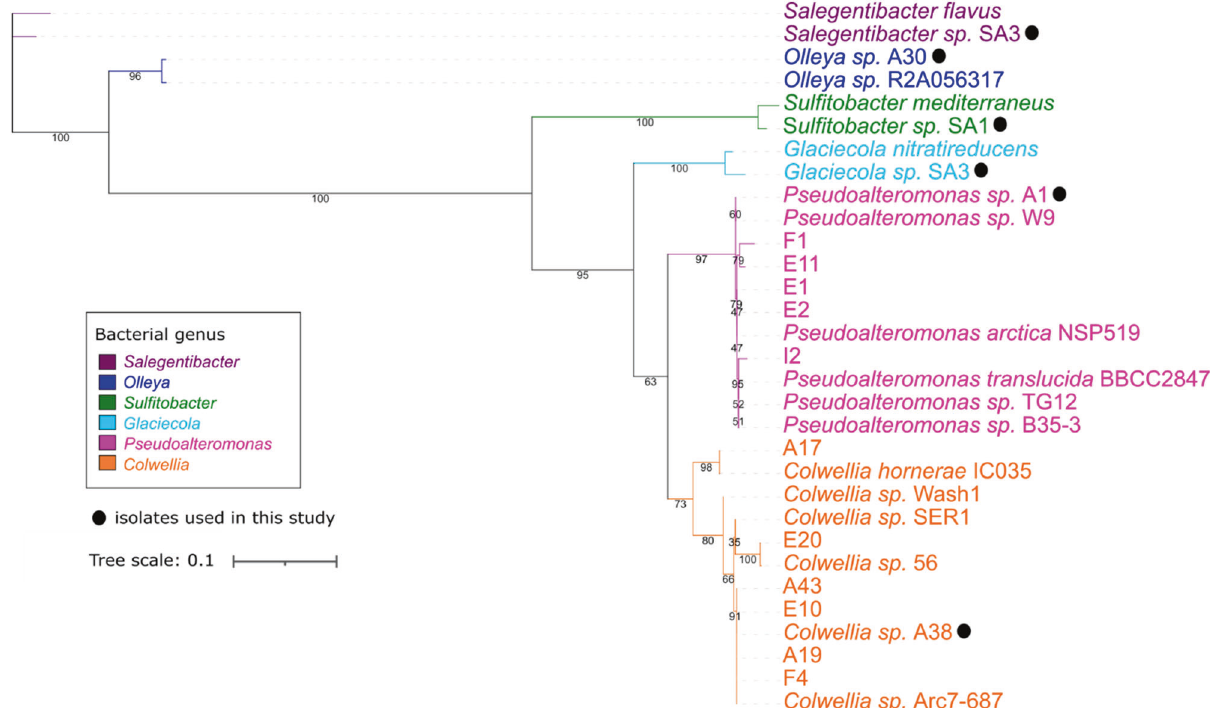
Fig. 2 Phylogenetic characterization of bacterial isolates. Phylogenetic tree based on 16S rRNA DNA sequences of indicated reference strains and bacterial isolates. Clades are color-coded by bacterial genera and isolates used for cocultures are indicated by a black circle. Class- level designation is as follows: Flavobacteria (purple and blue), Alphaproteobacteria (green), Gammaproteobacteria (cyan, pink, orange). Node values represent maximum likelihood